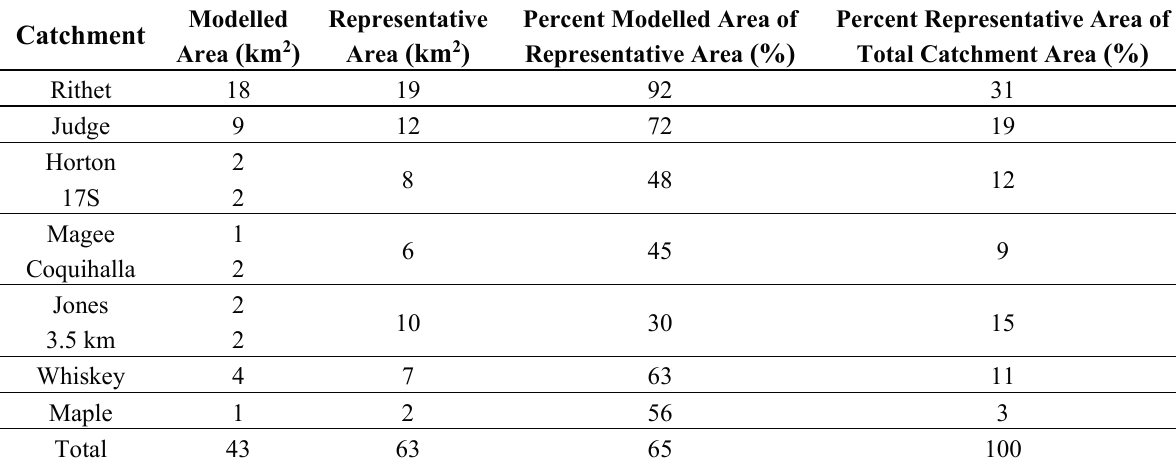
Table 2. Areas as modelled by HBV and their respective representative